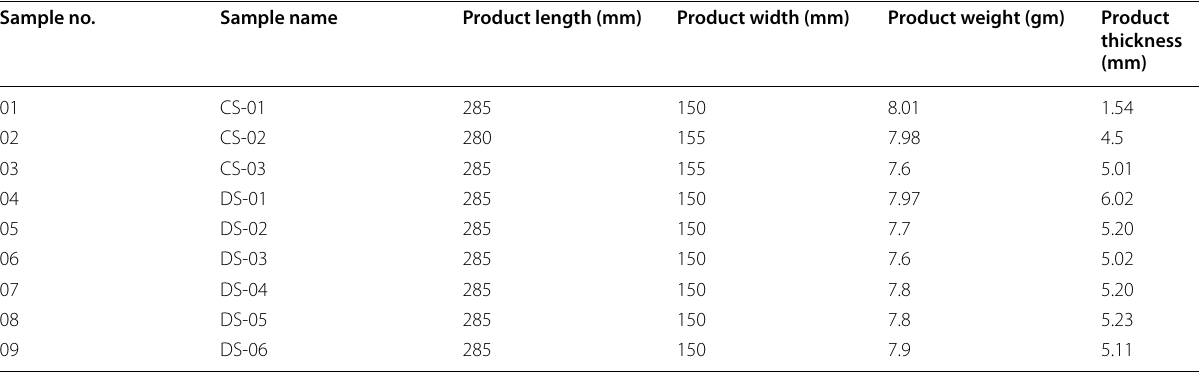
Table 4 Physical attributes of various sanitary napkin pad samples Sample